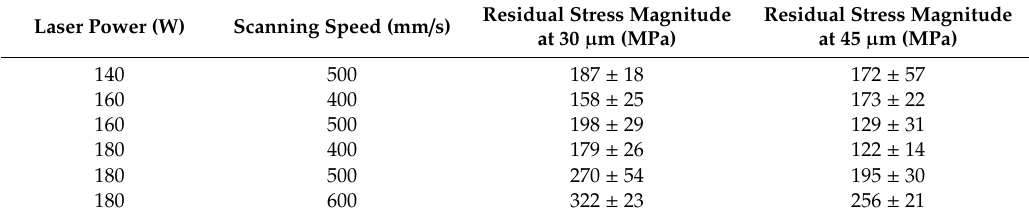
Table 3. Comparison of residual stress magnitudes for the layer thicknesses studied.